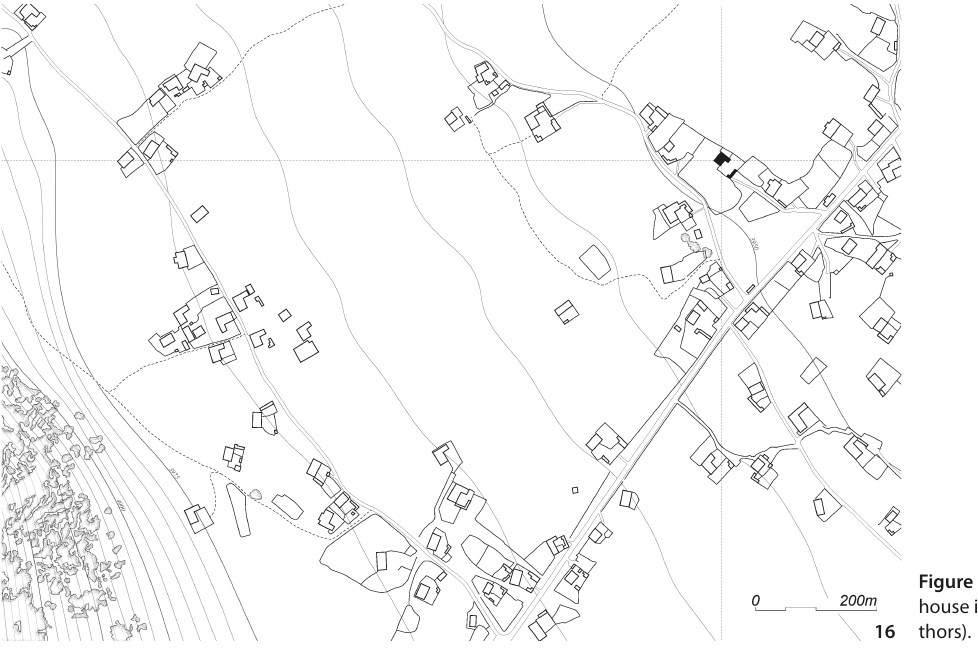
Figure 16 Site plan of the farm- house in Dabpa (Source: the au-